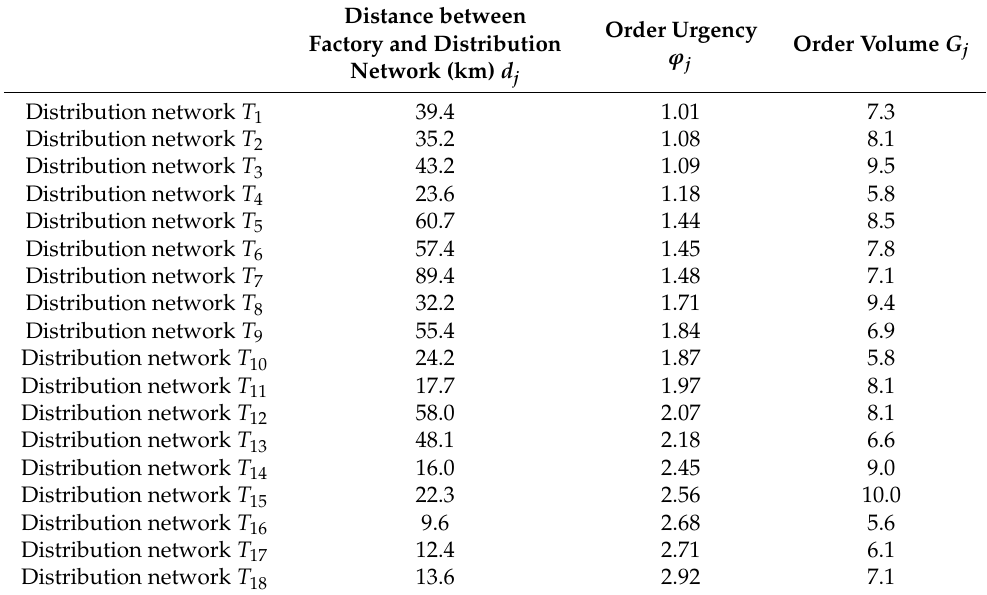
Table 3. Relevant data of factories and distribution